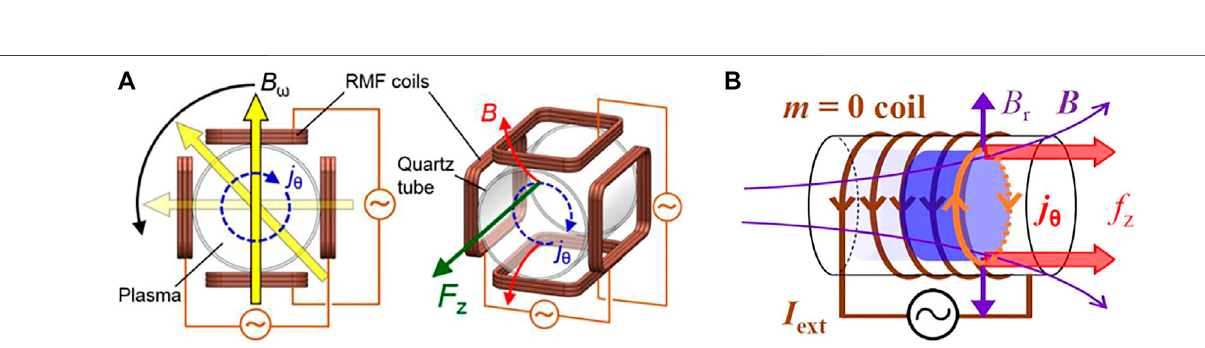
Frontiers in Physics |